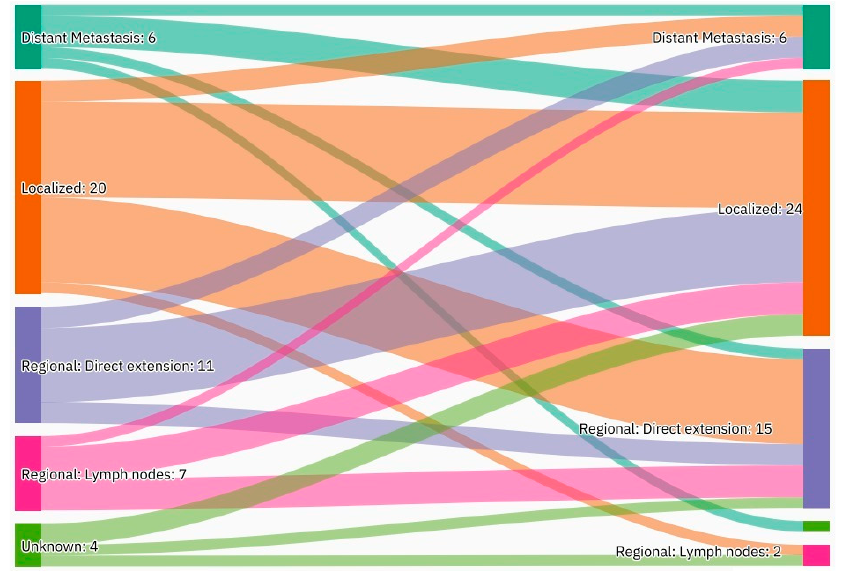
Figure 2. An alluvial plot showing stages of first and second primary malignancies. Detailed description: A total of 10.9% of the patients had their first primary malignancy diagnosis when it already metastasized to a distant organ, 21.8% had regional metastasis, and the rest had localized disease. A total of 16.8% of the patients had metastatic disease when diagnosed, 17.8% had regional metastasis, and the rest had localized disease.